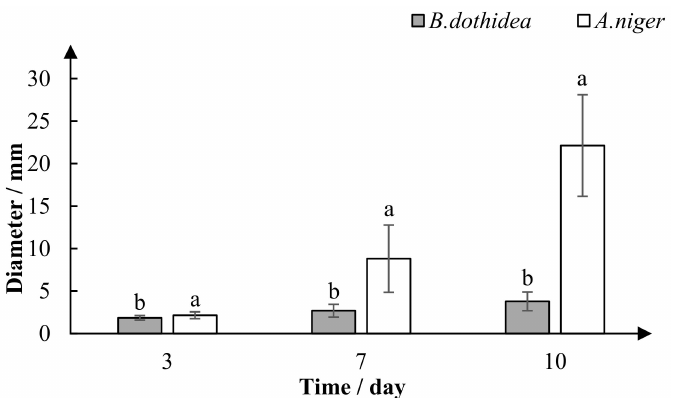
Figure 7. The change in lesion diameter from pomegranates infected by Aspergillus niger and Botryosphaeria dothidea. (The values are the means, and error bars indicate the standard deviations. Di ff erent letters (a / b) indicate significant di ff erences between two pathogens, n =